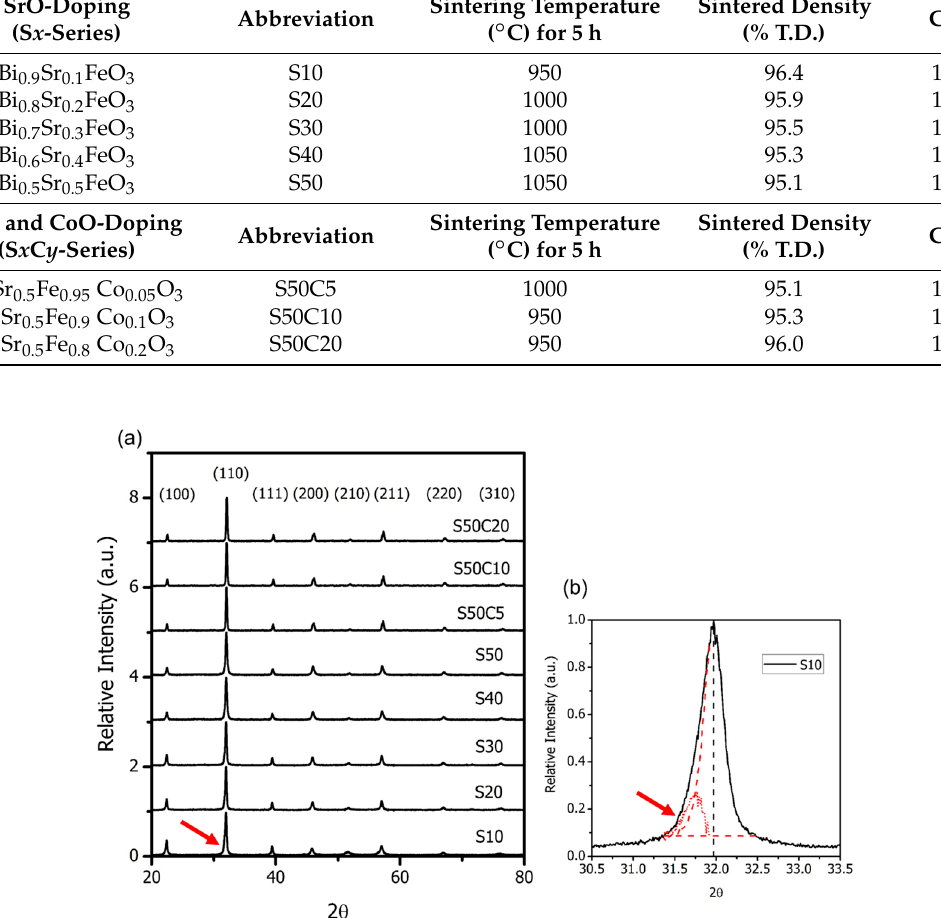
Figure 1. XRD patterns of bismuth ferrites with different Sr-doping and Co-doping contents in the range of 2 θ : ( a ) from 20° to 80°; and ( b ) from 30.5° to 33.5°. Note the (110) c peak of S10 sample after de-convoluted to two. The smaller one may belong to (104) r of a rhombohedral structure. The ferrite samples were densified to a relative density better than 95.0% T.D. (Table 1), and then